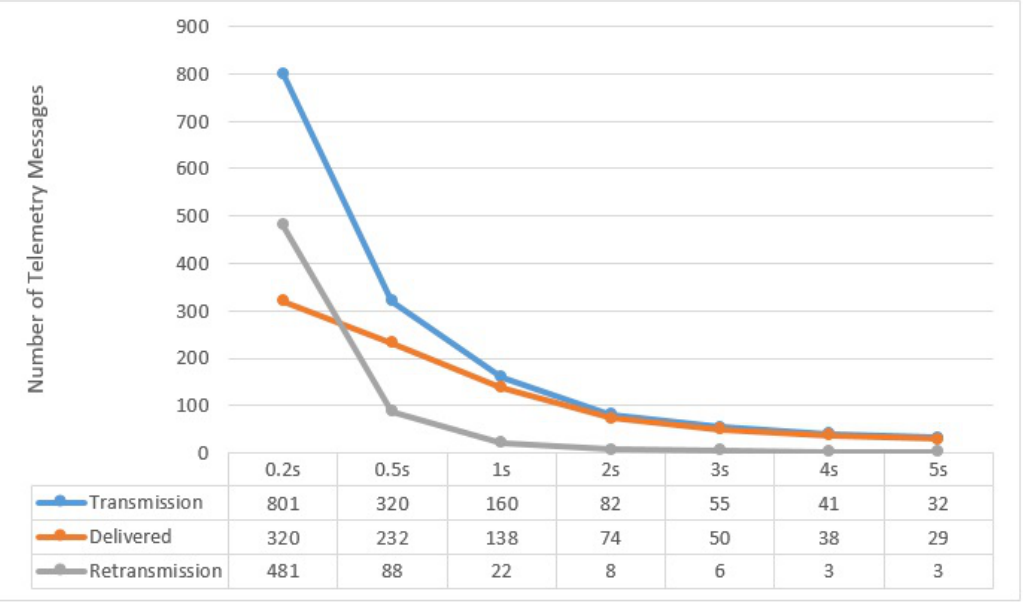
Figure 14. UAV to BS Communication at 10 m/s with respect to different Flush Back